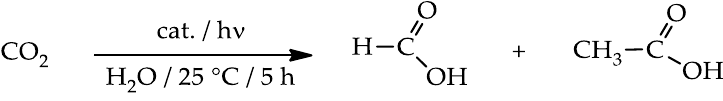
Scheme 2: Photoreduction of carbon dioxide. Scheme 2. Photoreduction of carbon